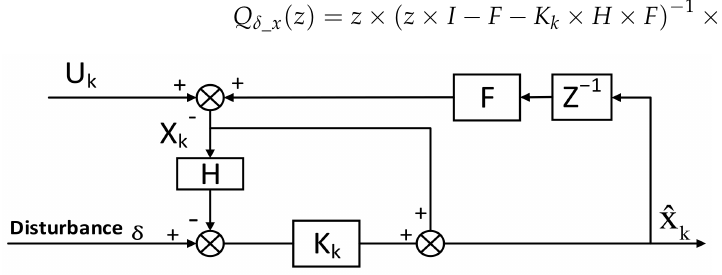
Figure 12. Structure of the Kalman